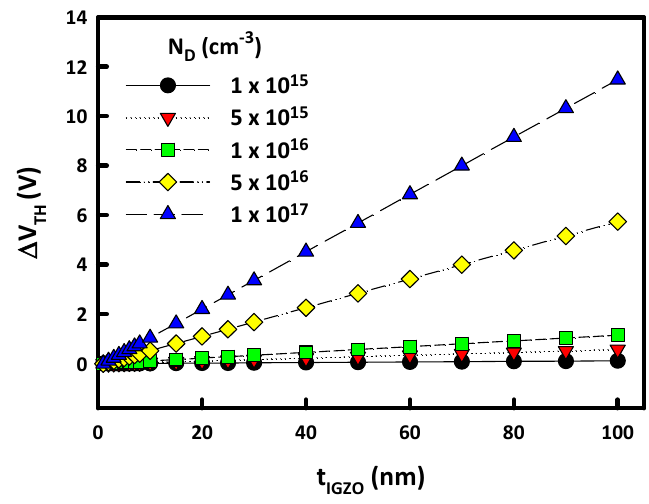
Figure 6. Threshold voltage ( V TH ) shift ( Δ V TH ) as a function of amorphous indium-gallium zinc-oxide thickness ( t IGZO ). V TH = CONST + q × N D × t IGZO / C OX , where C OX = 1.38 ×10 − 8 F/cm 2 , q = 1.6 × 10 − 19 C, and CONST represents the terms independent of t IGZO ; ( Φ M − Φ S ) + q × N bulk × ( E F − E i ) threshold / C OX − Q f / C OX + q × N int × ( E F − E i ) threshold / C OX − Q m / C OX . of N T = N int + t IGZO × N bulk , N int and N bulk were estimated to be 1.25 × 10 11 cm -2 eV − 1 and 1.07 × 10 17 cm − 3 eV − 1 , respectively (Figure 7).